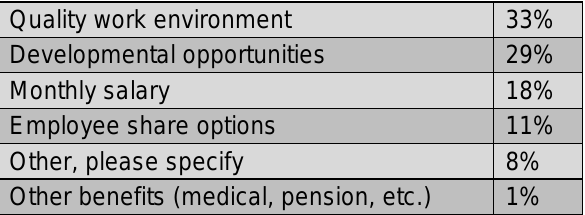
Other benefits (medical, pension, etc.) 1%